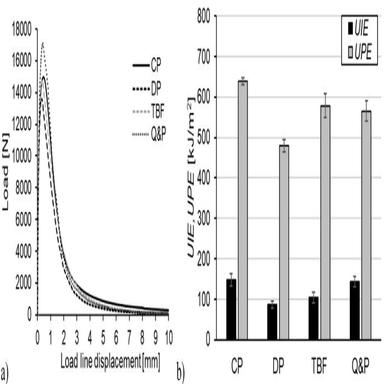
(a) Load vs load-line displacement curves from Kahn-type tear tests. Only one representative curve per material is plotted. (b) UIE and UPE for the investigated AHSS.